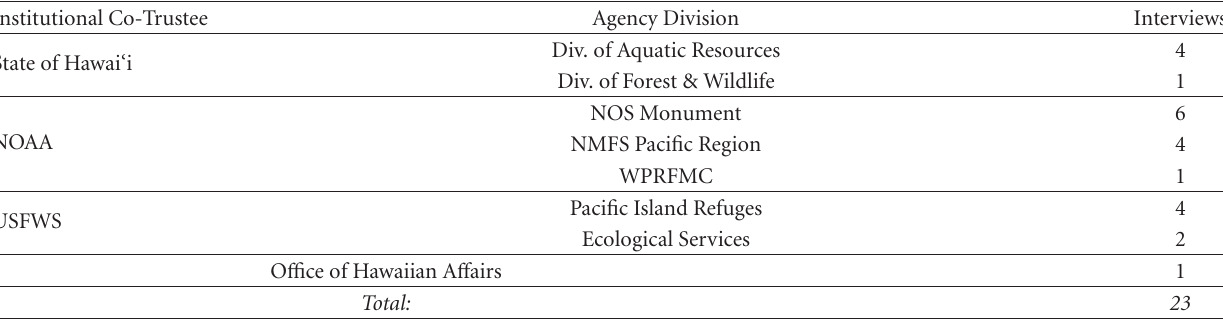
Table 1: Summary of interviews by agency division for 23 natural resource managers involved in the management and planning of the Papah¯anaumoku¯akea Marine National Monument. Abbreviations are as follows: NOAA: National Oceanic and Atmospheric Administration; USFWS: U.S. Fish and Wildlife Service; NOS: National Ocean Service; NMFS: National Marine Fisheries Service; WPRFMC: Western Pacific Regional Fishery Management Council; Div.: Division.